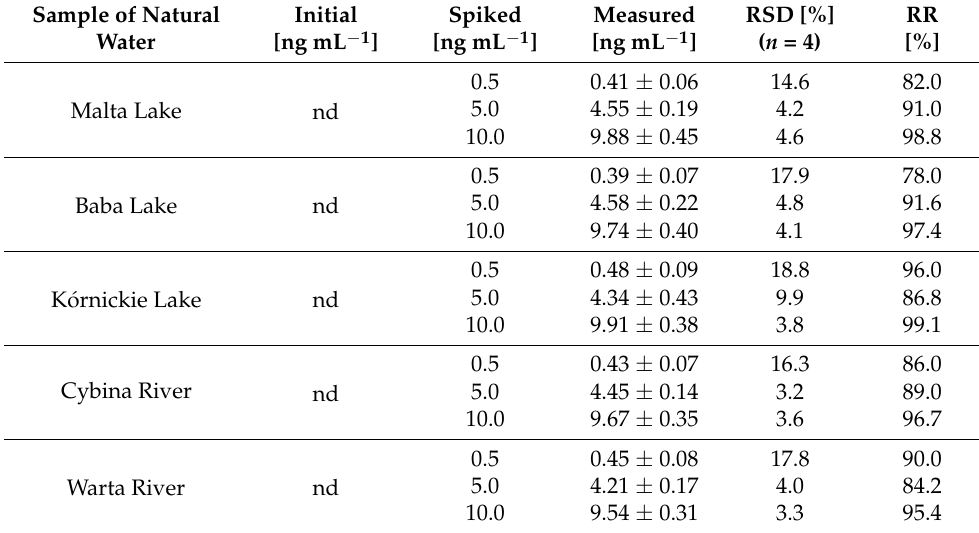
Table 3. The results for the determination of formaldehyde in surface water samples.